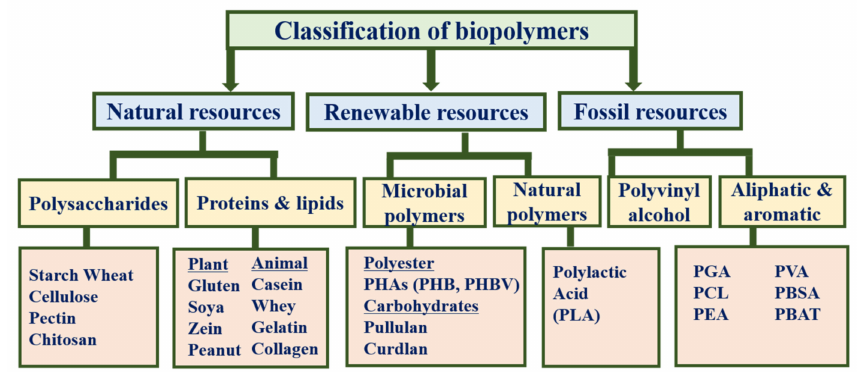
Figure 5. Classification of biopolymers for food packaging